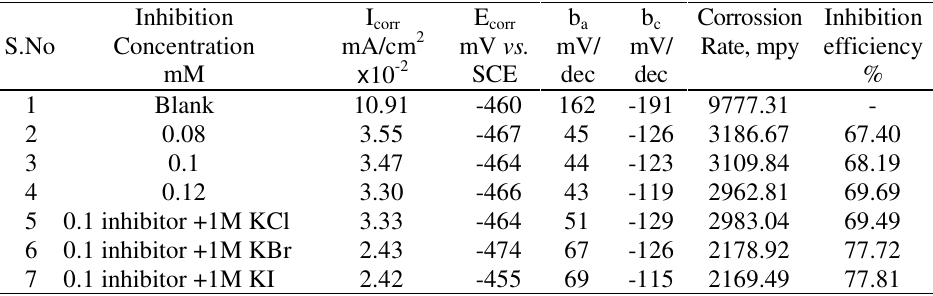
Table 4. Potentiodynamic polarization parameters for the corrosion of mild steel in 1 M H SO with and without (01TD) 2 4